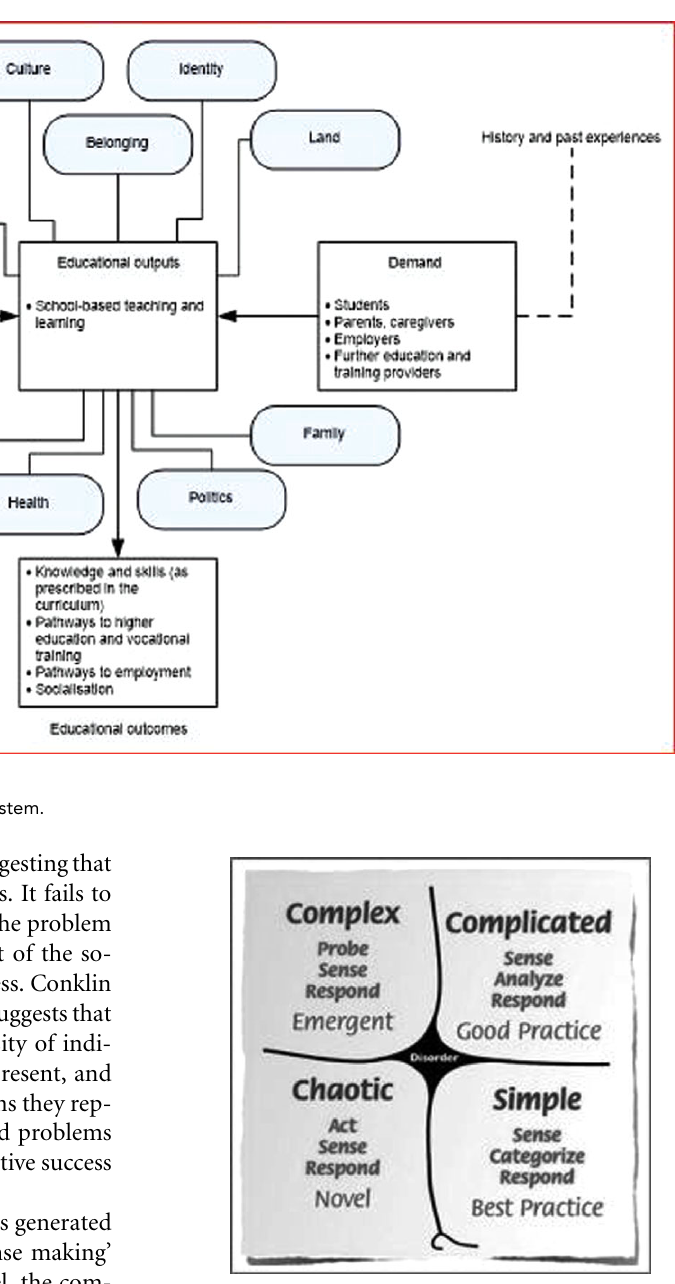
Cynefin sense-making model (Snowden,